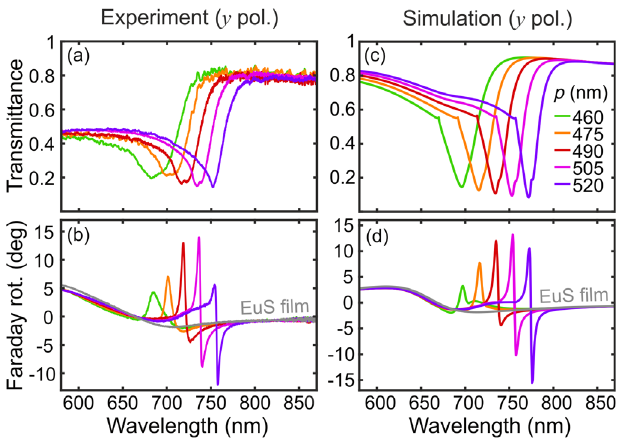
FIG. 4. The left-hand column displays the measured trans- mittance (a) and Faraday rotation (b) for y -polarized incident light for a wire width of 75 nm, burial parameter b ¼ 33 nm, and different grating periods p . The experimental data agree well with the performed simulation shown in the right-hand column (c),(d). For a period of 505 nm, the Faraday rotation reaches values of up to